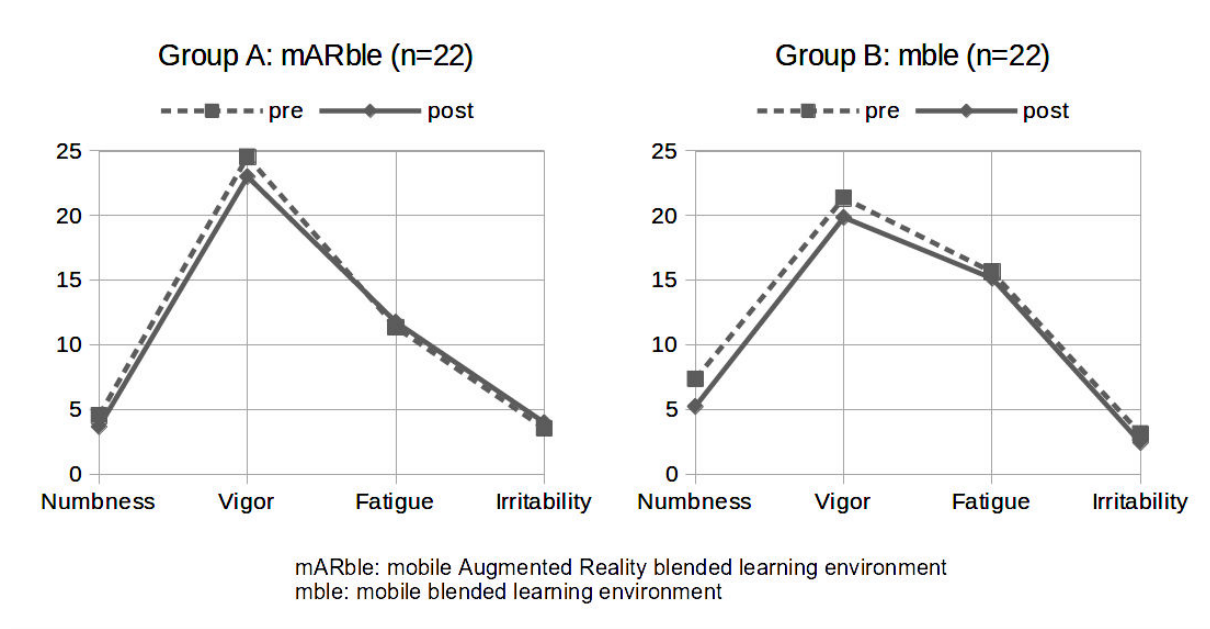
Figure 5. Aggregated values for irritability, fatigue, vigor, and numbness.